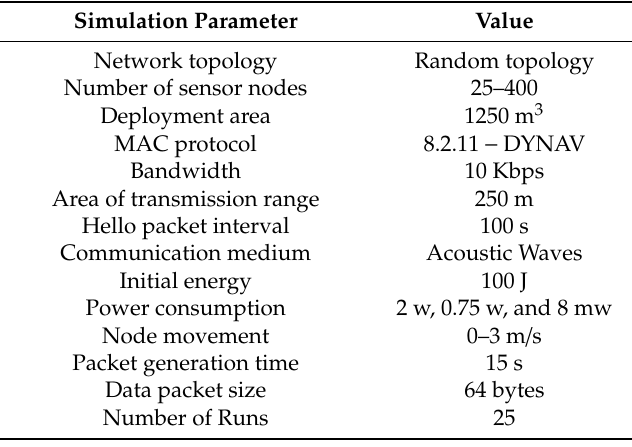
Table 1. The underwater network simulation parameter